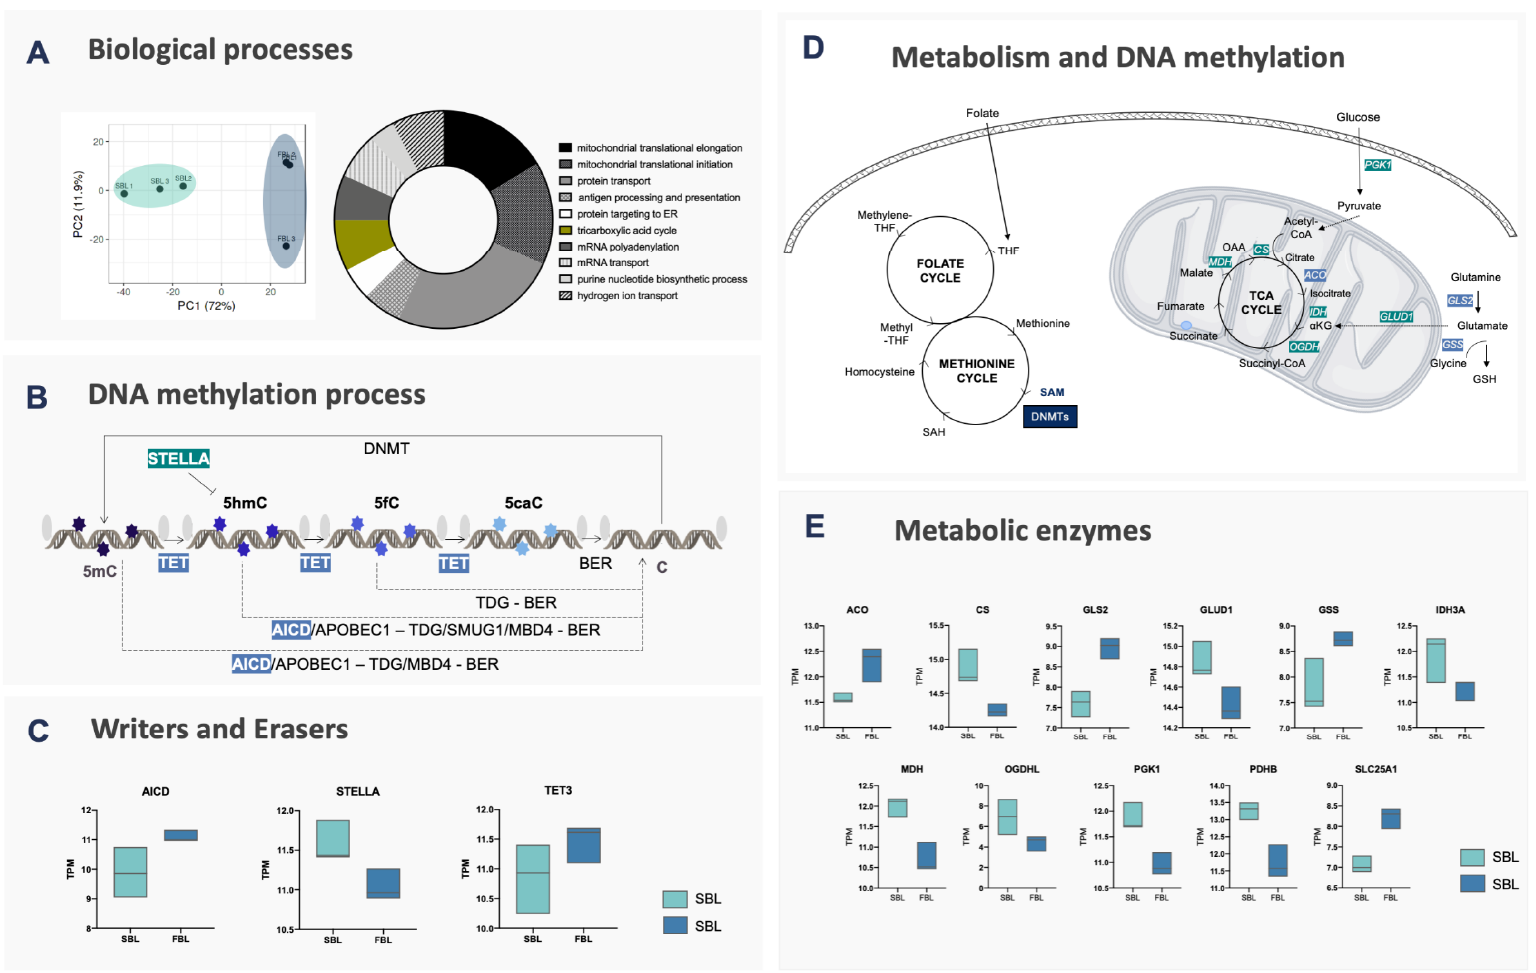
Figure 2 Figure 2. Molecular evidence for fast and slow blastocysts. ( A ) PCA and gene ontology analysis of RNA-Seq data. Fast and slow blastocysts are highlighted in light blue and light green, respectively. The most affected biological processes are indicated in the Doughnut chart, according to the number of genes involved in each